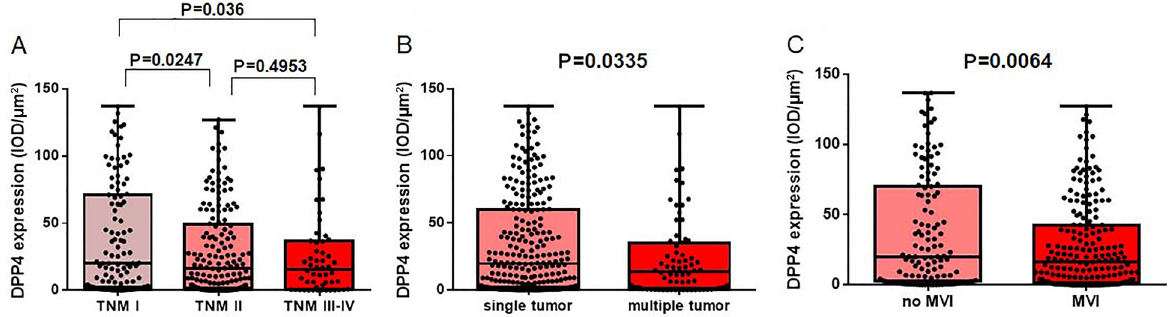
Figure 2. Expression of dipeptidyl peptidase 4 (DPP4) in ( A ) subgroups of TNM stage, ( B ) tumor number, and ( C ) microvascular invasion of tissues (MVI) of patients with hepatocellular carcinoma (HCC). Data are reported as median and interquartile range (chi-squared test).